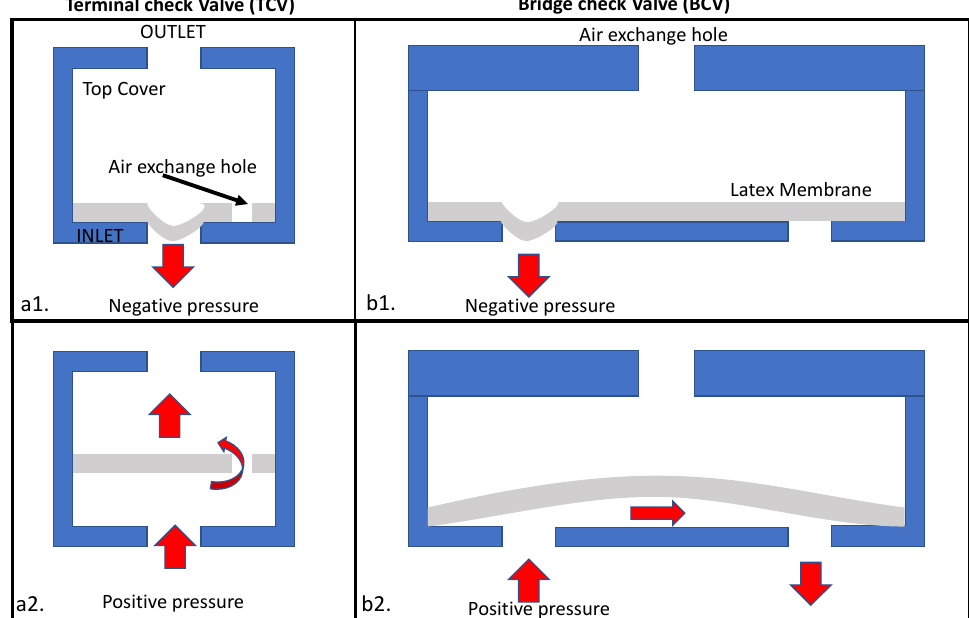
Figure 16. ( a1 ) The first design of an air pressure-based check valve or the terminal check valve (TCV). Negative pressure is blocked by bending the latex membrane and blocking the flow. ( a2 ) The TCV under positive pressure, which allows the fluid to pass through the air-exchange hole. This will occur only until the membrane is held in the middle. When it touches the outlet wall, the flow is blocked again. ( b1 ) The bridge check valve or BCV. Negative pressure deforms the latex membrane and blocks the fluid flow. ( b2 ) Positive pressure deforms the latex membrane to allow the fluid to pass into the outlet on the same side of the chamber. The figure was reconstructed from a source cited [64]. Permission was granted by the publisher to